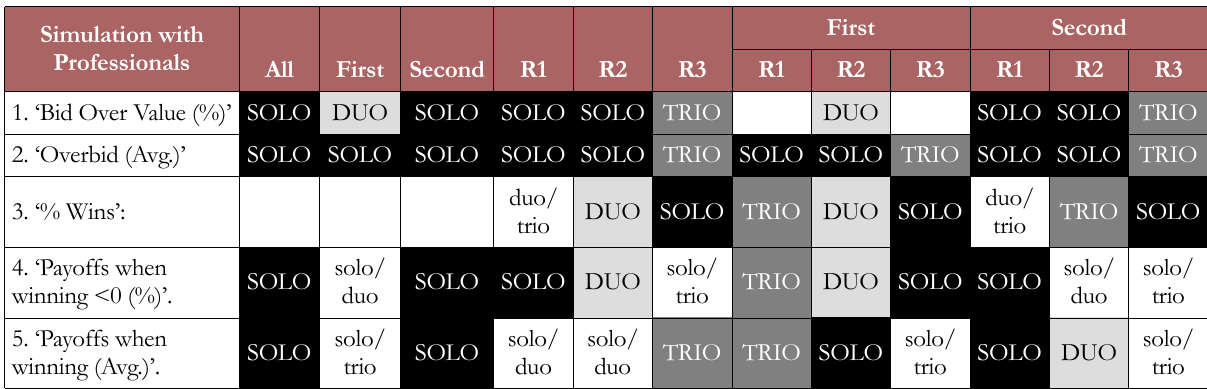
Table 10. Summary of comparisons with virtual